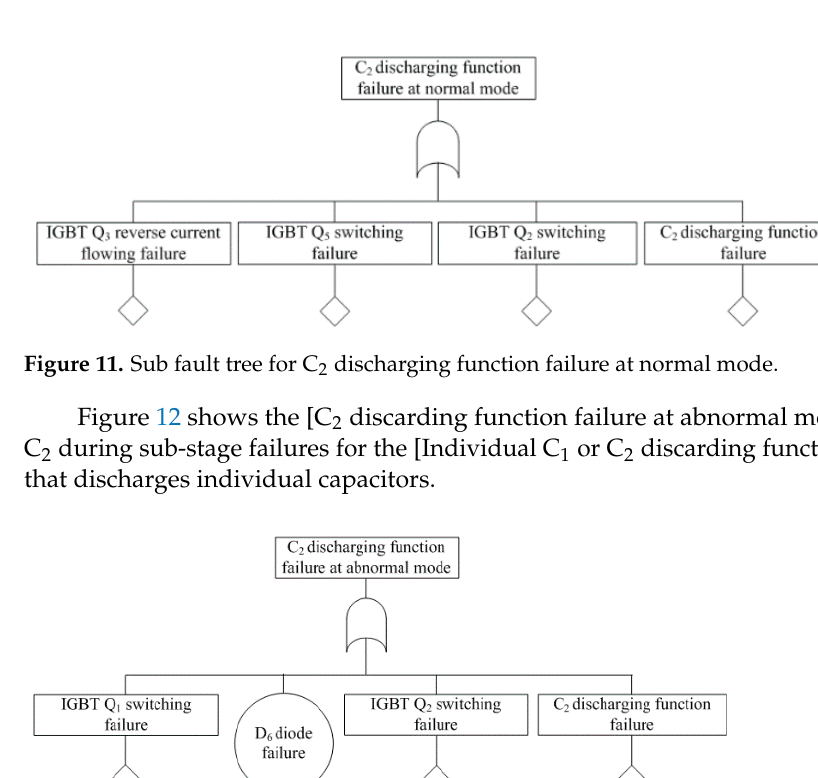
Figure 12. Sub fault tree for C 2 discharging function failure at abnormal mode.